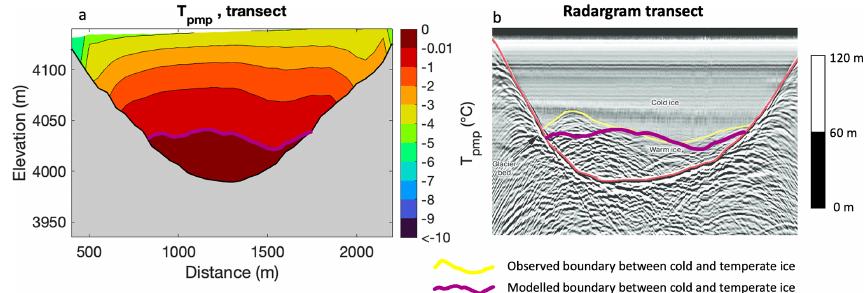
Figure 10. Validation of the thermal regime with a GPR profile showing the boundary between cold and temperate ice. The purple line is the modelled boundary between cold and temperate ice, while the yellow line corresponds to the observed boundary between cold and temperate ice. Panel (b) is a radargram reproduced from Petrakov et al. (2014) with permission from the publisher. The figure clearly shows two sections of cold (upper part) and temperate (lower part) ice. The latter is characterised by the presence of small hyperbolic diffraction features due to the presence of liquid water in the ice, typical for temperate (shown here as warm) ice.